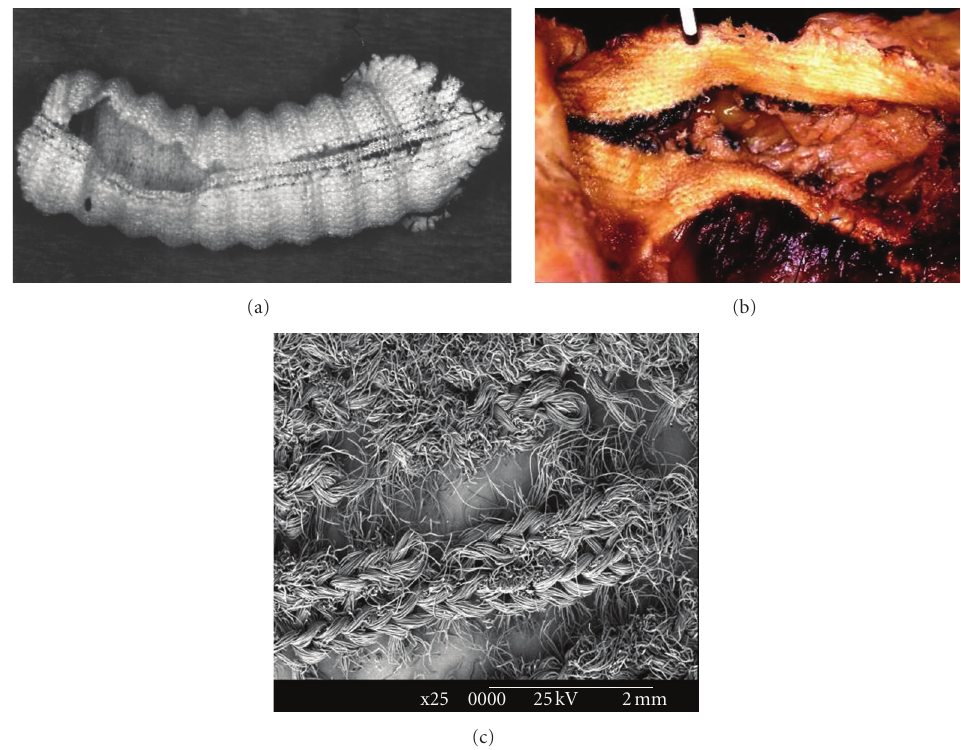
Figure 2: Macroscopic examination of Cooley Double Velour prosthesis: (a) ruptures on remeshing line. (b) rupture on guide line. (c) scanning electron microscopy examination of Cooley Double Velour prosthesis presenting a rupture on remeshing line.